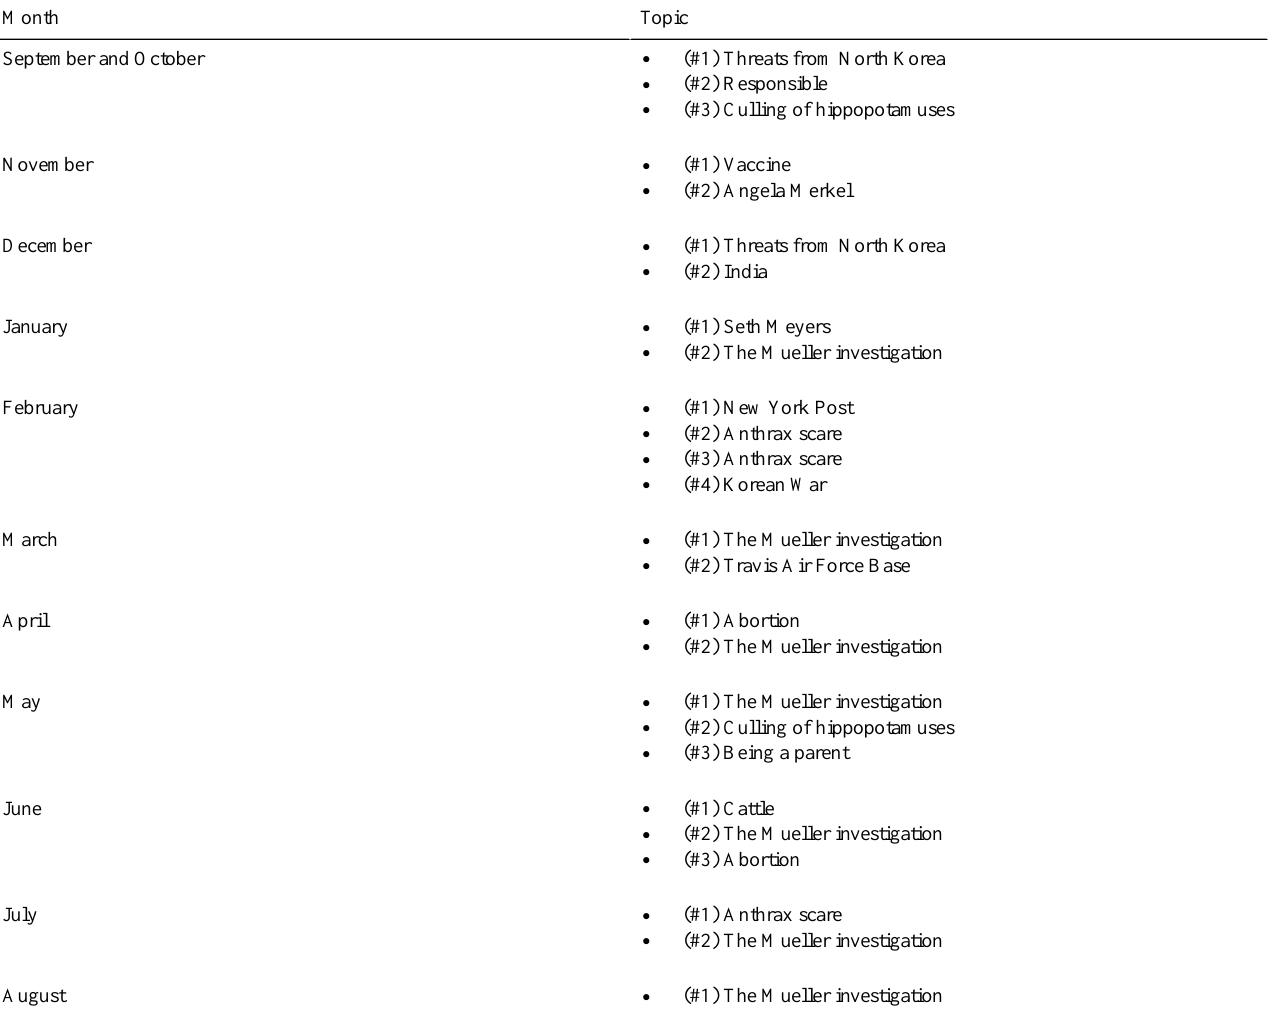
Table 3. Results of topic modeling for each month of data collection (September 25, 2017 to August 15, 2018) (N=26 topics).